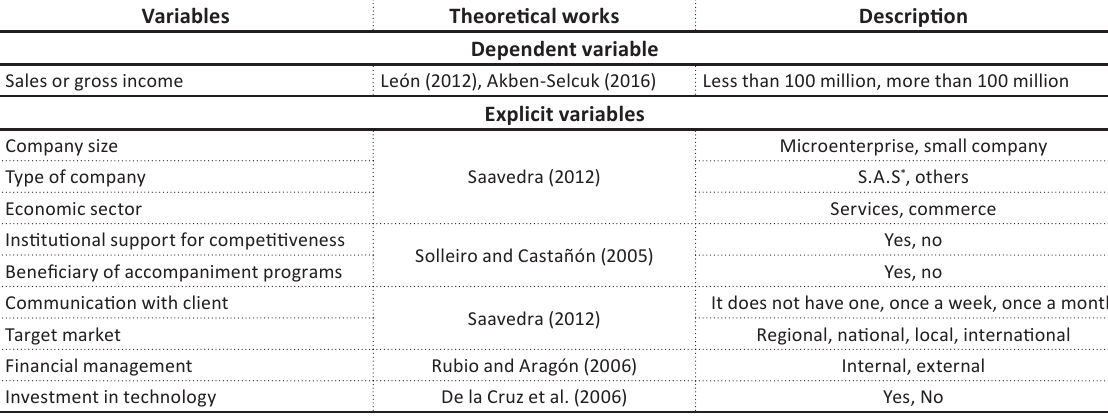
Table 1. Definition of variables object of